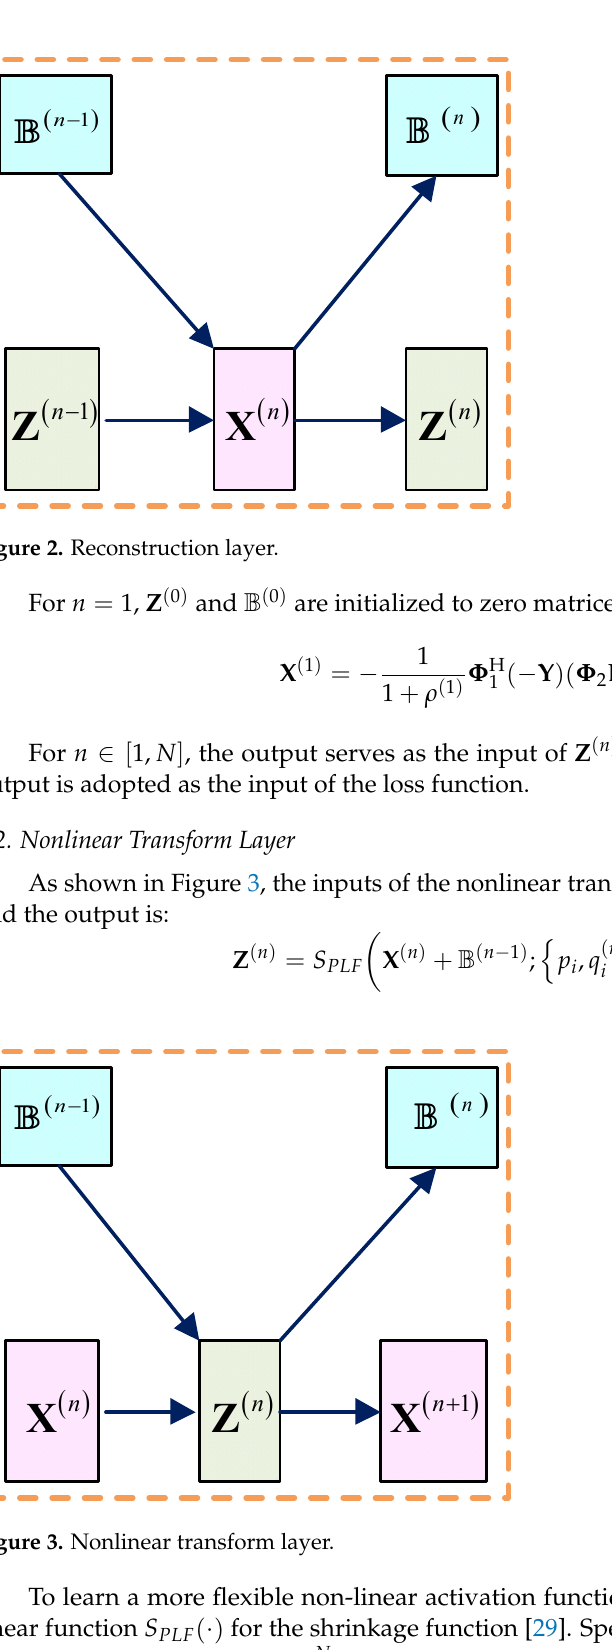
Stage n Figure 1. Structure of the 2D ‐ ADN. 3.1. Reconstruction Layer As shown in Figure 2, the inputs of the reconstruction layer are   1 n  Z and   1 n   , and the output is: